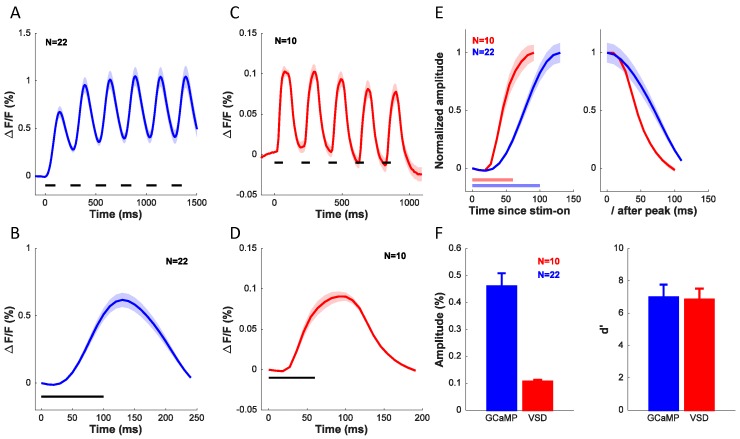
Comparison of dynamics, signal amplitude and signal sensitivity between GCaMP and VSD.(A) Time course of GCaMP signal in response to a grating flashed for 6 cycles at 4 Hz. (B) Average response from (A) collapsed across the 6 cycles. (C) Time course of VSD signal in response to a grating flashed for 5 cycles at 5 Hz. (D) Average response from (C) collapsed across the 5 cycles. (E) Dynamics of rising edge (left) and falling edge (right) of GCaMP and VSD. (F) Average amplitude (left) and sensitivity (right) of GCaMP and VSD signals. Horizontal lines in A–E indicates timing of stimulus presentation. When collapsing the response across cycles in A–E, the responses to each cycle were first anchored by subtracting the mean response in the first 36 ms (4 frames) for VSD and 50 ms (1 frame) for GCaMP after stimulus onset. Results from the same experiments as in Figure 6C.